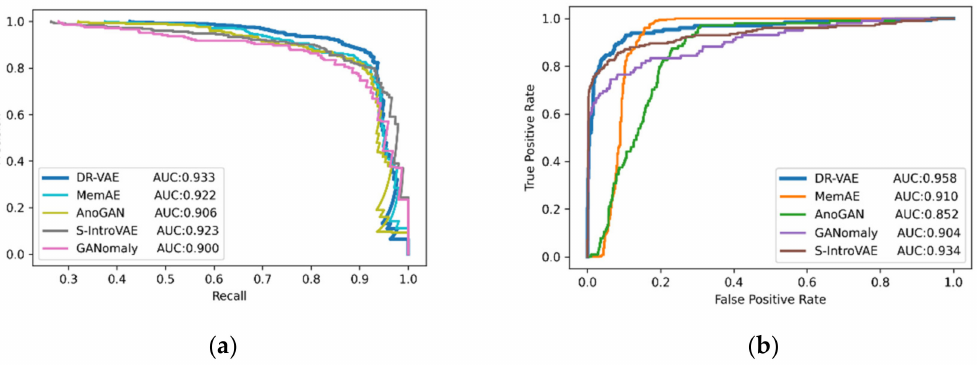
Figure 10. Comprehensive performance comparison experiment: ( a ) PR curve; ( b ) ROC curve.